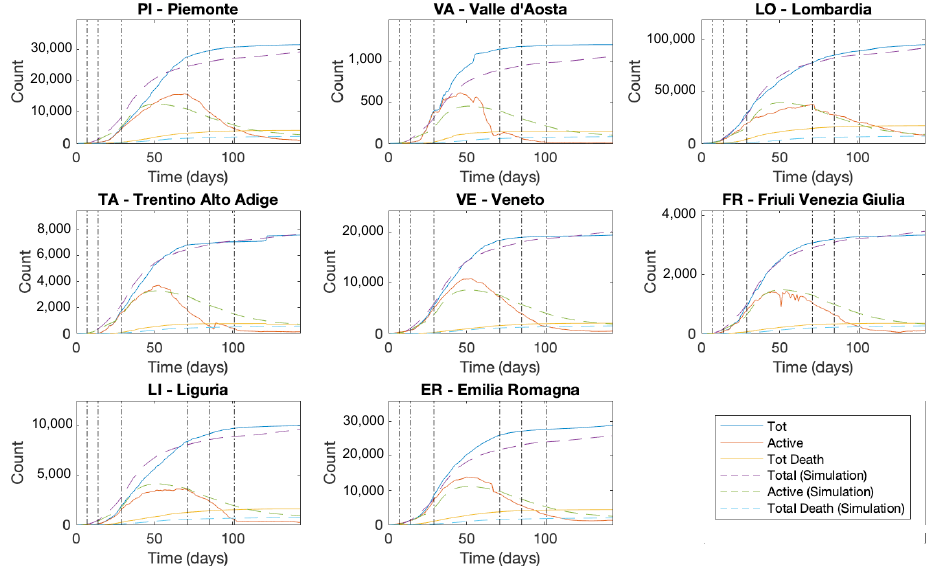
Figure 3. Real plots versus model results for each